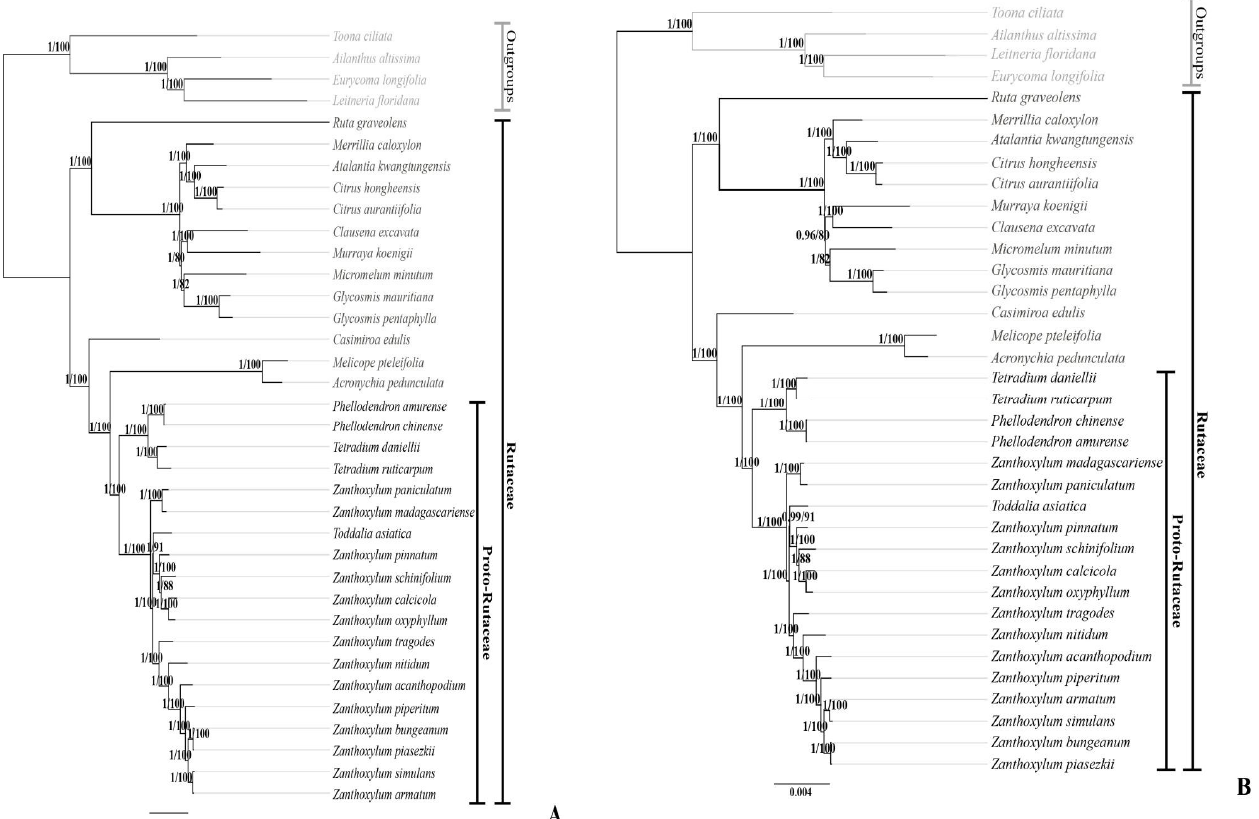
Figure 6. Phylogenetic relationships of 36 Rutaceae species constructed by MrBayes (BI) and maximum likelihood (ML) methods. ( A ) Phylogenetic tree based on the complete chloroplast genomes. ( B ) Phylogenetic tree based on the protein encoding genes. The numbers at each node show the posterior probabilities (PP) according to BI and bootstrap support (BS) values obtained by ML,